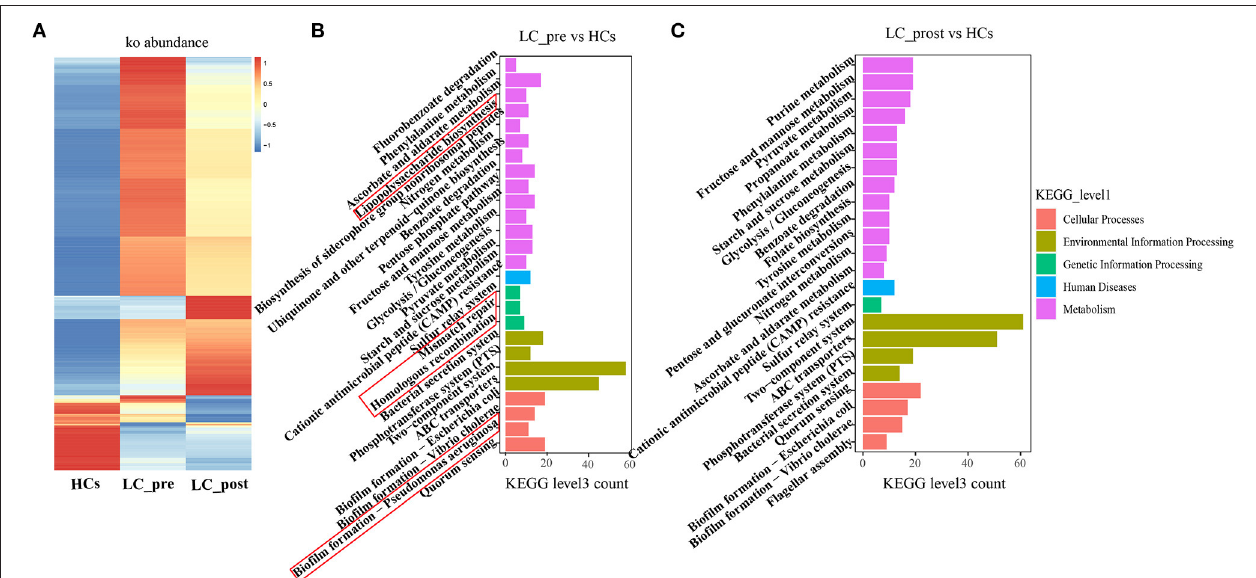
FIGURE 3 | KEGG pathway enrichment analyses. (A) Heatmap analysis shows the difference among the cirrhotic patients before (LC-pre) and after (LC-post) lactitol intervention and healthy controls (HCs). (B) the number of differential KEGG metabolism level 3 from LC-pre vs. HCs. (C) Abundance of differential KEGG metabolism level 3 from LC-post vs. HCs. KEGG, Kyoto Encyclopedia of Genes and